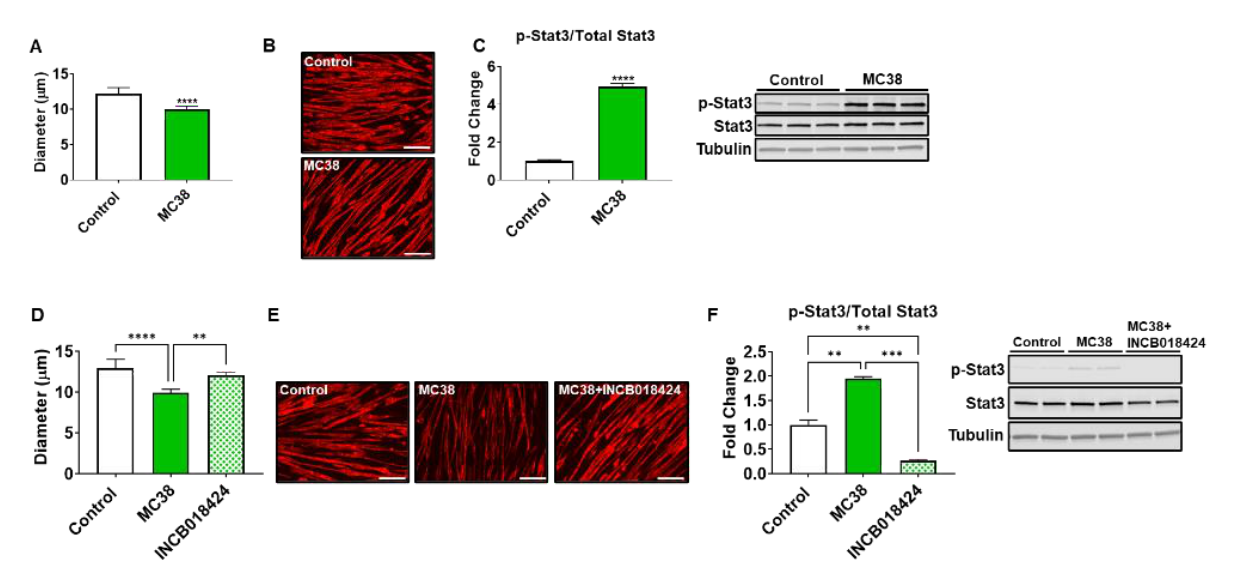
Figure 7. MC38 tumor-derived factors induce atrophy of C2C12 myotubes. Co-culturing of C2C12 myotubes with MC38 tumor cells for 48 h was performed, followed by assessment of myotube diameter ( n = 400) ( A ). Myotubes were stained with anti-MHC ( B ). Representative Western blotting and protein quantification (fold-change vs. control) for phosphorylated and total STAT3 ( n = 3) ( C ). Follow-up experiments were performed co-culturing MC38 tumor cells and C2C12 myotubes with or without INCB018424 (400 nM). Quantification of myotube diameter ( n = 400) ( D ). Myotubes were stained with anti-MHC ( E ). Representative Western blotting and protein quantification (fold-change vs. control) for phosphorylated and total STAT3 ( n = 2) ( F ). Scale bars: 100 µm. Data presented as mean ± s.d. ** p < 0.01, *** p < 0.001, **** p < 0.001.